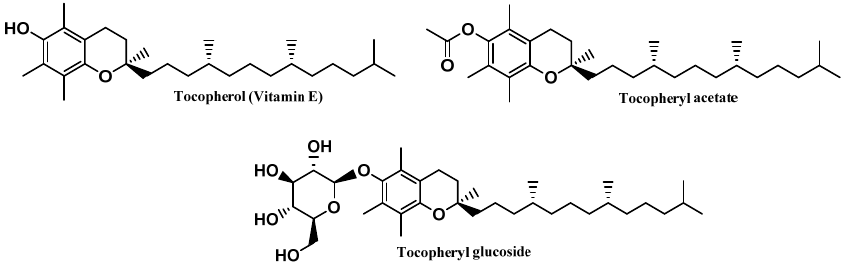
Figure 7. Chemical structure of vitamin E and its